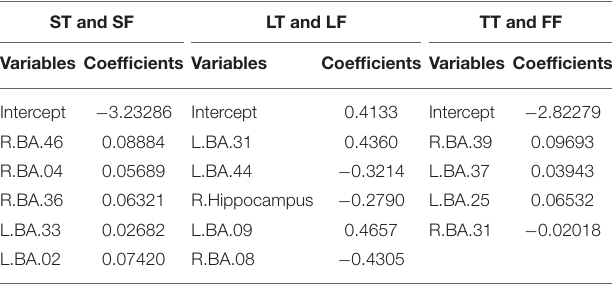
TABLE 3 | Coefficients in logistic regression for best